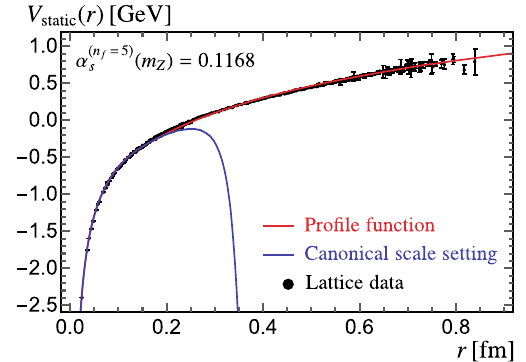
Fig. 8 ComparisonoftheR-improvedperturbativestaticpotentialwith lattice QCD results for n f = 3 dynamical flavors. We use μ = R , with μ set to the profile shown in Fig. 6. We determine α s and R 0 fitting our pNRQCD theoretical expression to the lattice